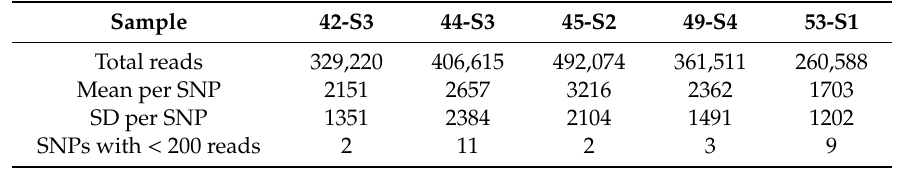
Table 1. Summary statistics of number of reads obtained with the VISAGE BT A&A (PSeq) assay for casework-type samples. “Mean per SNP” indicates the average read depth per single nucleotide polymorphism (SNP) and “SD per SNP” is the standard